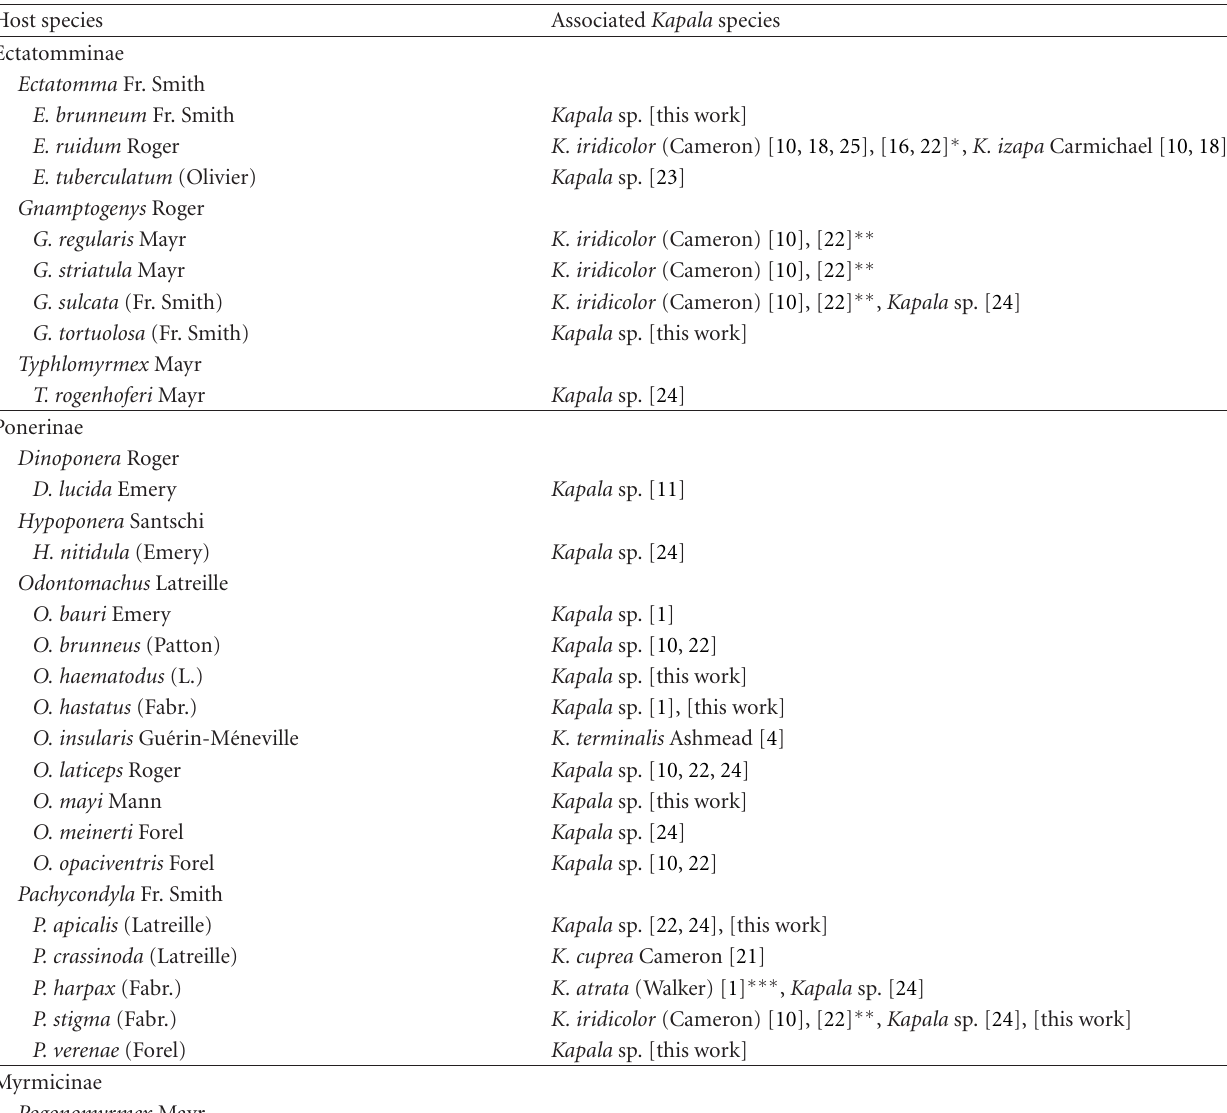
Table 2: Known ant host species associated with the eucharitid genus Kapala